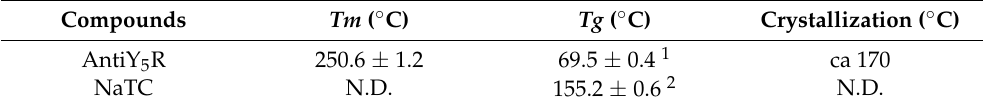
Table 2. Thermal properties obtained by DSC analysis for AntiY 5 R and NaTC.